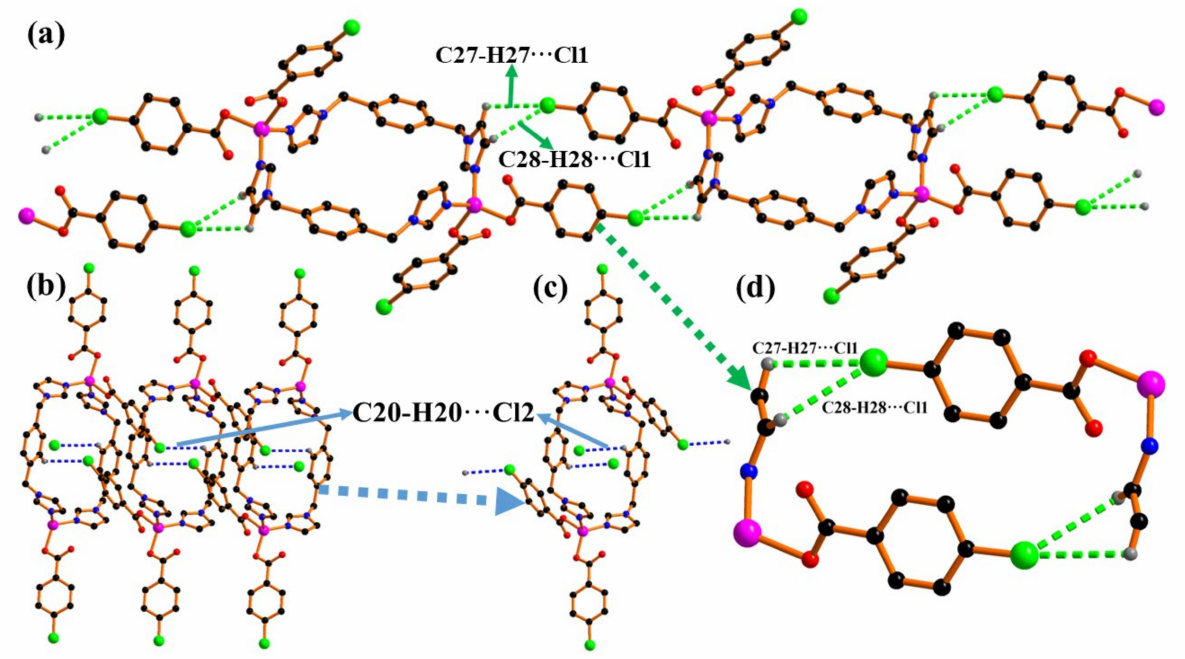
Figure 8. ( a ) The 1D chain constructed by C27–H27/C28–H28 ··· Cl1 interactions in 2 . ( b ) The 1D chain constructed by a pair of C20–H20 ··· Cl2 interactions in 2 . ( c ) The enlarged C20–H20 ··· Cl2 interactions in 2 . ( d ) The enlarged C27–H27/C28– H28 ··· Cl1 interactions in 2 . The bond distances between H27/H28 and Cl1 are 3.175 Å and 3.125 Å; the bond angles of C27–H27/C28–H28 ··· Cl1 are 104 ◦ and 107 ◦ , which fall slightly below the preferred minimum hydrogen bond angle of 110 ◦ ; and the distances between C27/C28 and Cl1